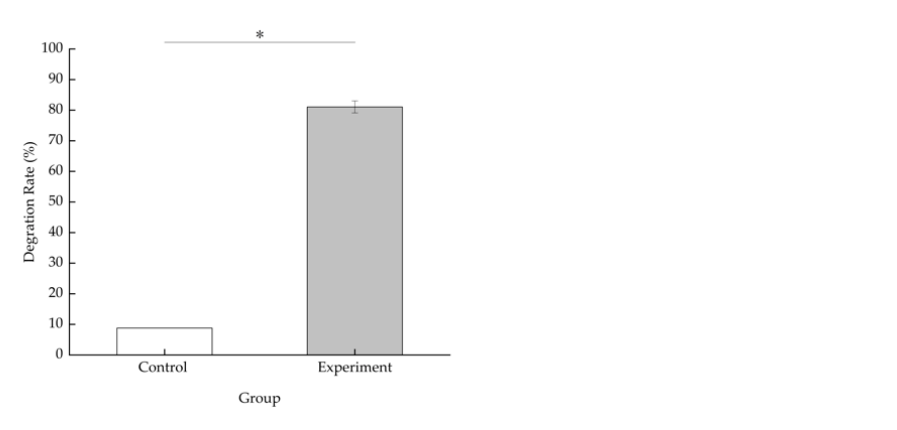
Figure 6. Total ion chromatogram of BDE-209 degrading culture (TAW-CT127) extract. 3.4. Genome Information of Strain TAW-CT127 3.4.1. Genomic Properties of Strain TAW- CT127 In this study, Illumina MiSeq sequencing technology was used to complete genome scanning and sequencing of the strain, and an Illumina PE library (5000 bp) was constructed. After quality control of the sequencing data, bioinformatics analysis was performed to complete whole-genome scanning. Table 2 shows the final genomic information. TAW-CT127 was assembled into one scaffold of a 5,395,558 bp circular chromosome with a G + C content of 70.44%. There were 55 tRNAs and 1 rRNA in the TAW-CT127 genome.